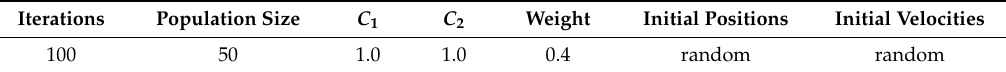
Table 4. Particle swarm optimization parameters.